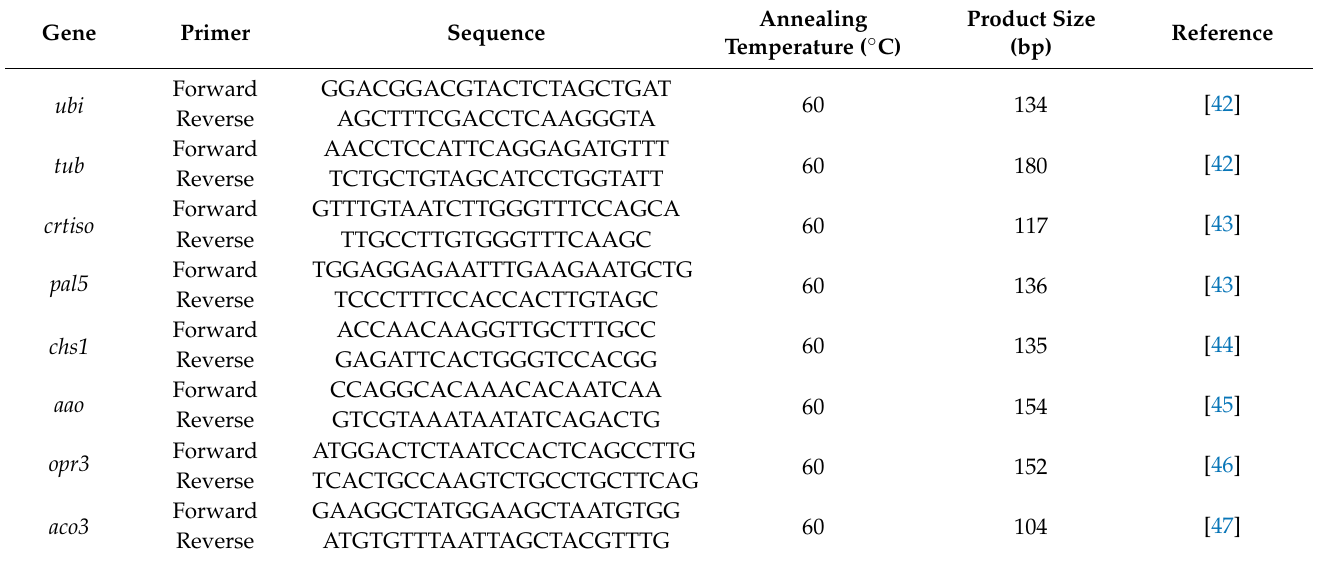
Table 1. Primer’s sequence and annealing temperature of the selected genes for tomato phenyl- propanoid and hormonal